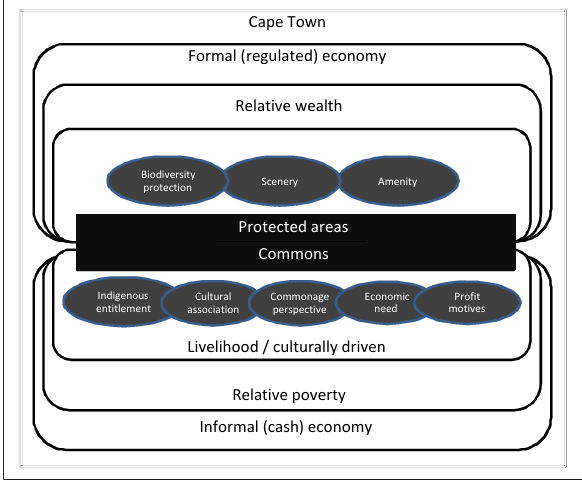
Theoretical framework highlighting anthropogenic perspective differences for Cape Town